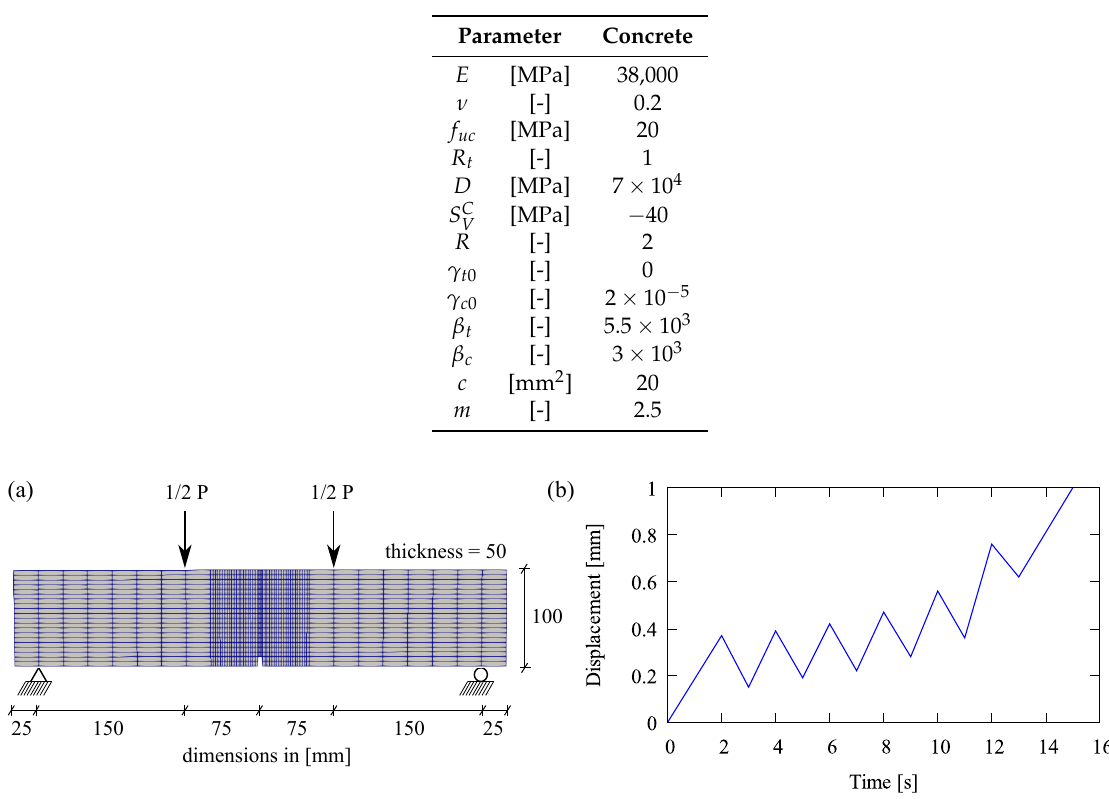
Table 1. Model parameters for four-point bending test.